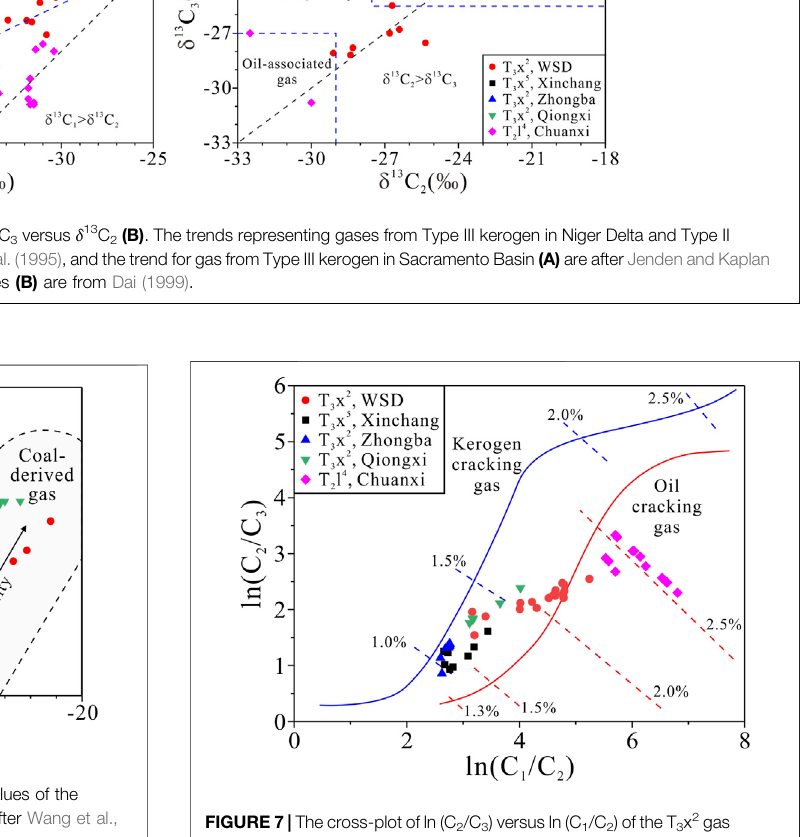
Frontiers in Earth Science |